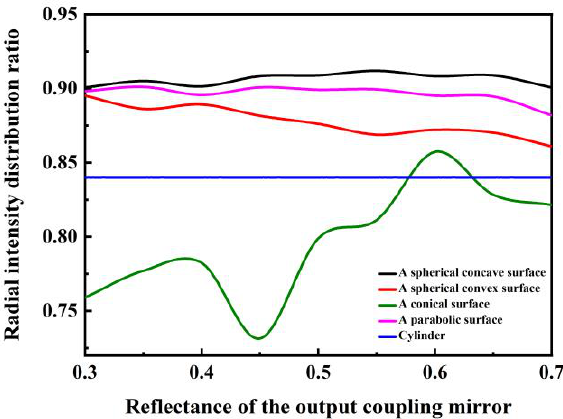
Figure 8. Radial intensity distribution ratio of the laser using five different kinds of saturated absorbers versus reflectance of the output coupling mirror.